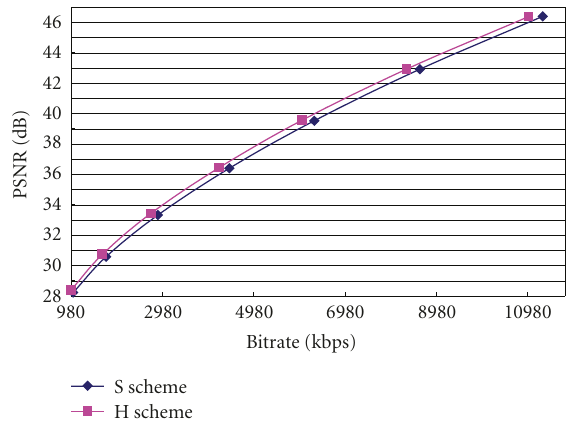
Figure 7: RD curves of encoding City (CIF) sequence with S scheme and H scheme.